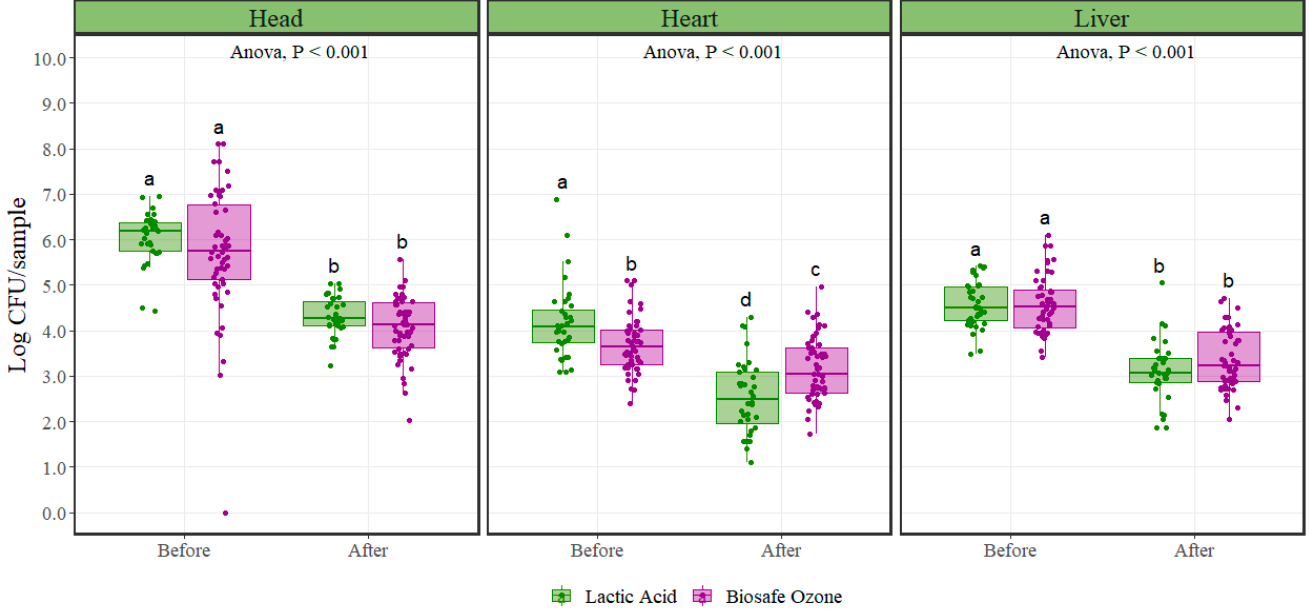
Figure 1. Mesophilic aerobic plate counts (Log CFU/sample; equivalent to Log CFU/100 cm 2 ) before and after lactic acid and ozone interventions on variety meats (n = 54 per treatment). In each boxplot, the horizontal line crossing the box represents the median, the bottom and top of the box are the lower and upper quartiles, the vertical top line represents 1.5 times the interquartile range, and the vertical bottom line represents 1.5 times the lower interquartile range. a–d For each individual variety meat, boxes with different letters are significantly different according to ANOVA analysis followed by a pairwise comparison T -test at P < 0.05. The points represent the actual data points.